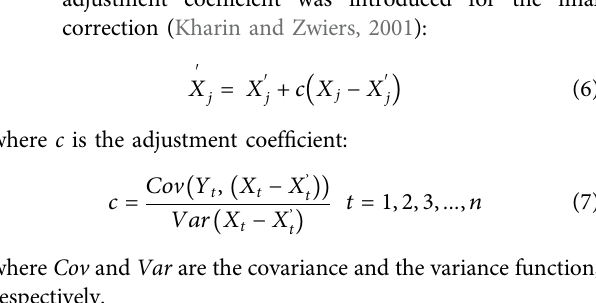
Frontiers in Earth Science |